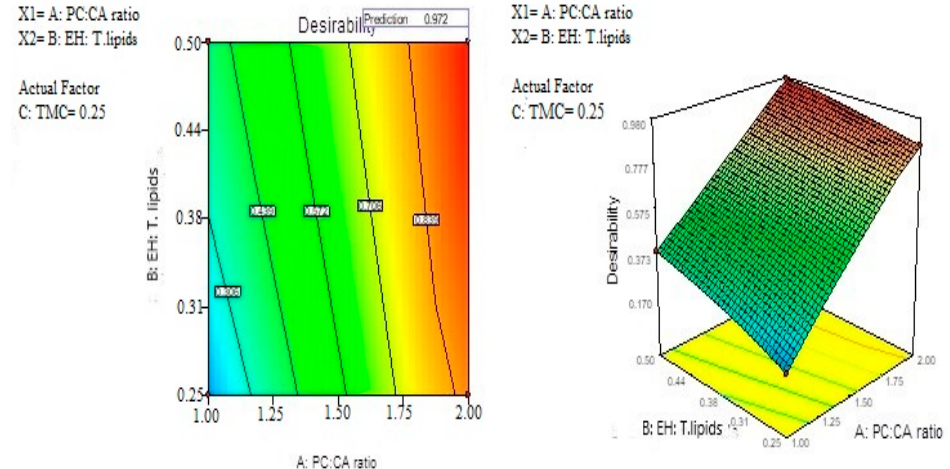
Figure 3. Optimization of EH mucoadhesive emulsomes.